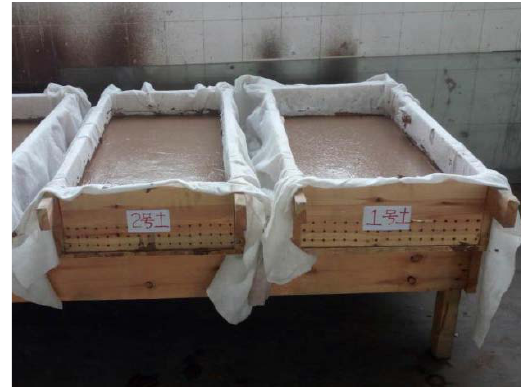
Figure 6. Soil sample remodeling.